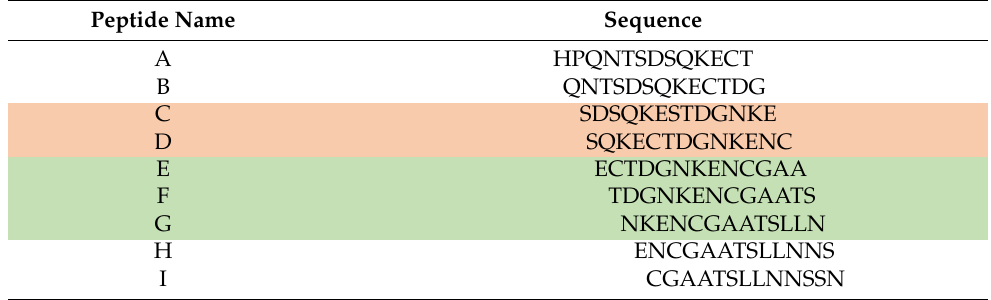
Table 3. Peptide array used to probe antibody specificities, peptides C-D encompass the 9H4 epitope (orange) and peptides E-G contain the 4D11 epitope